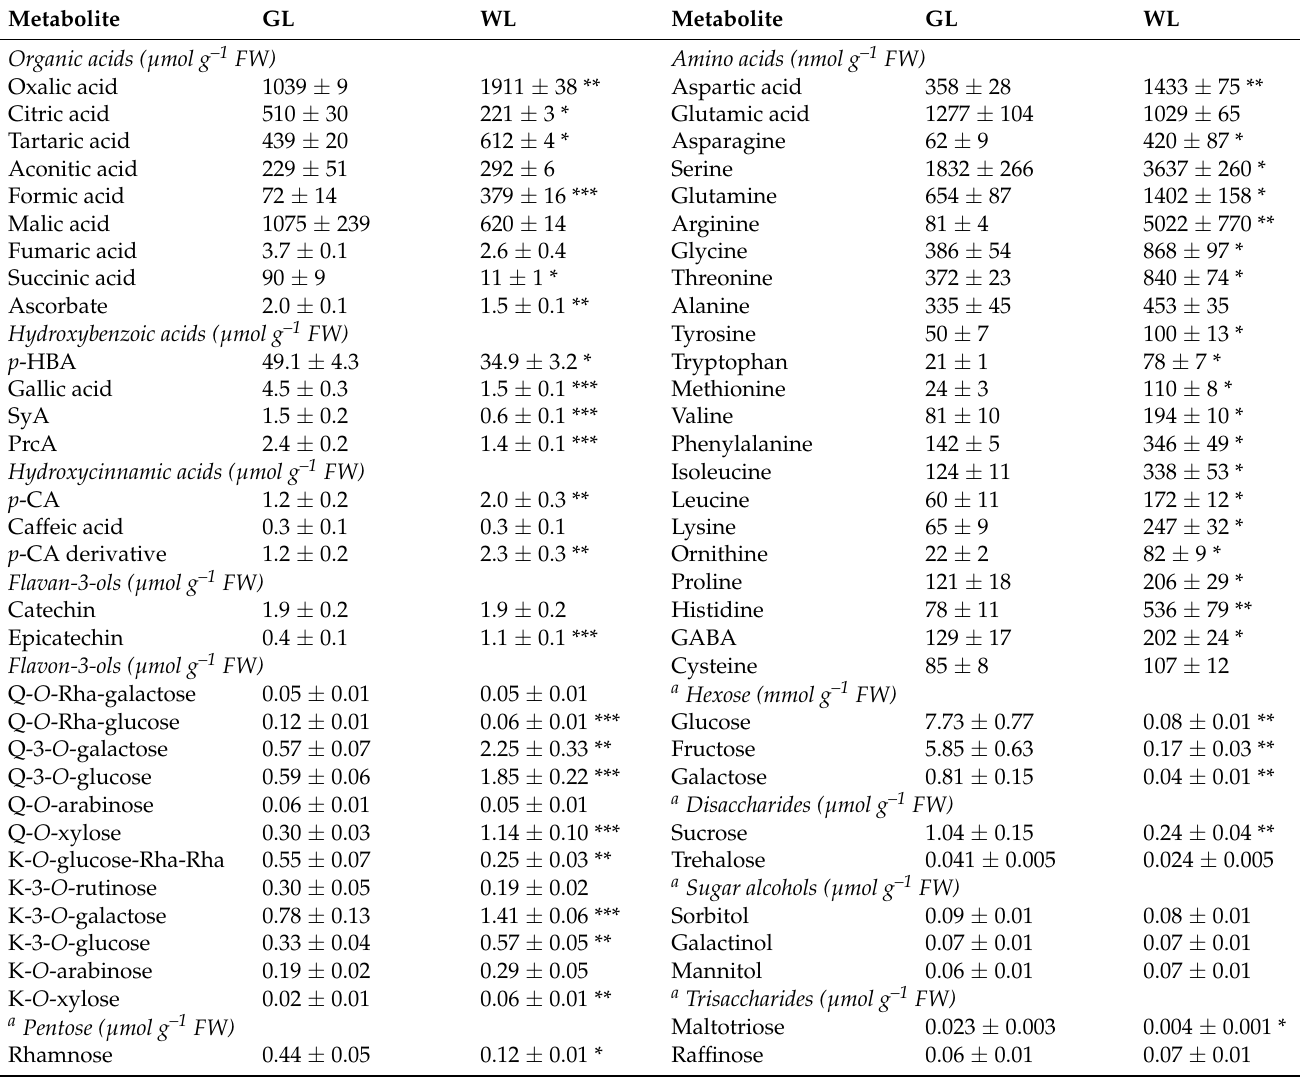
Table 1. Content of selected metabolites in GL and WL of P. zonale